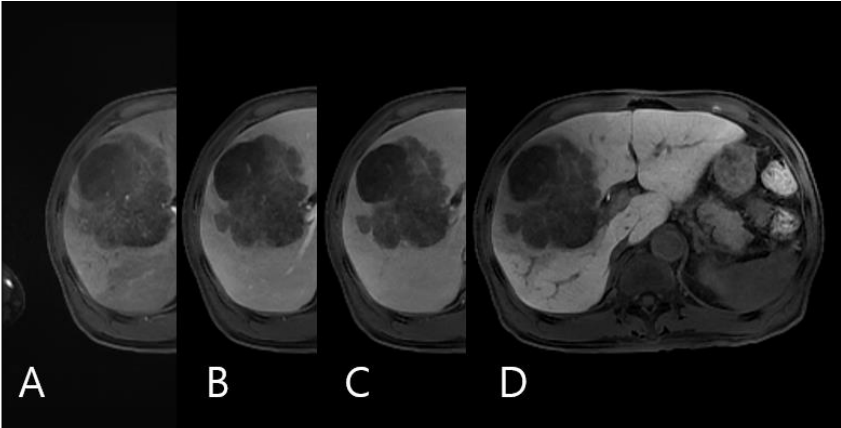
Figure 1. Liver ethoxybenzyl diethylenetriamine pentaacetic acid-enhanced magnetic resonance imaging Images. ( A ) Arterial phase, ( B ) portal phase, ( C ) venous phase, ( D ) and hepatobiliary phase.